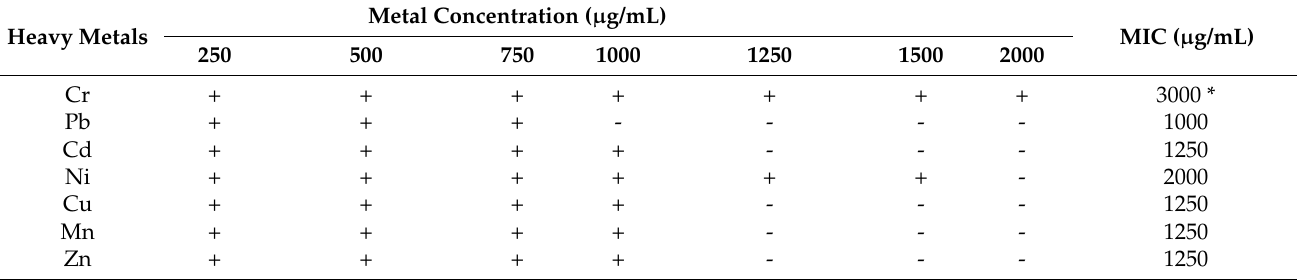
Table 2. Multi-metal and antibiotic tolerance of the rhizobacterial strain